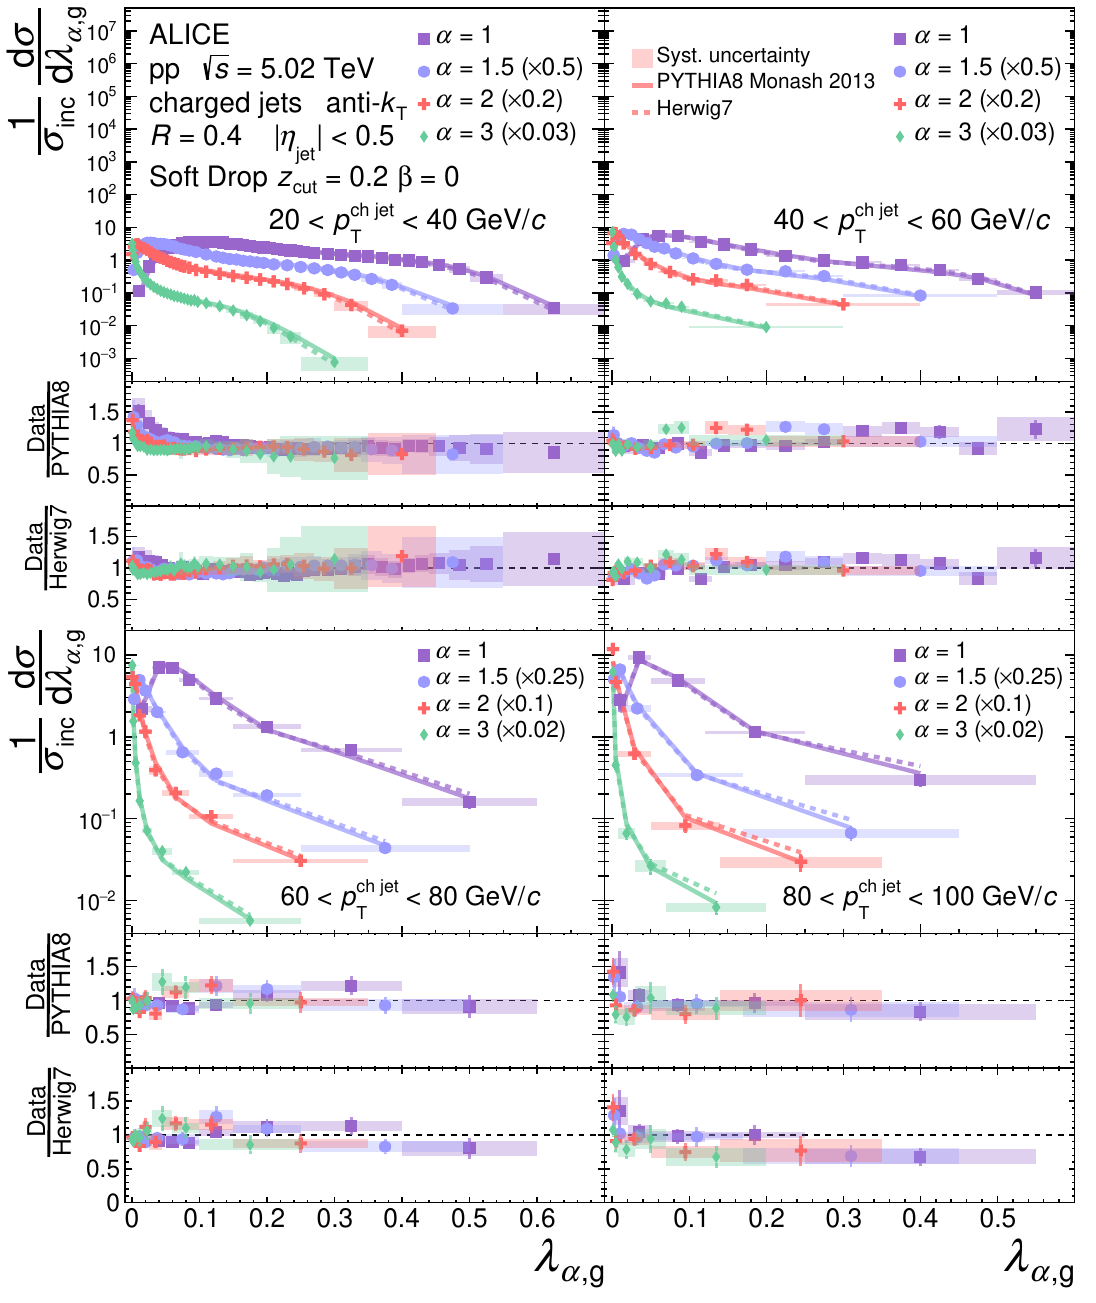
Figure 3 . Comparison of groomed jet angularities λ α, g in pp collisions for R = 0 . 4 to MC predictions using PYTHIA8 and Herwig7, as described in the text. Four equally-sized p ch jet between 20 and 100 GeV /c . The distributions are normalized to the groomed jet tagging